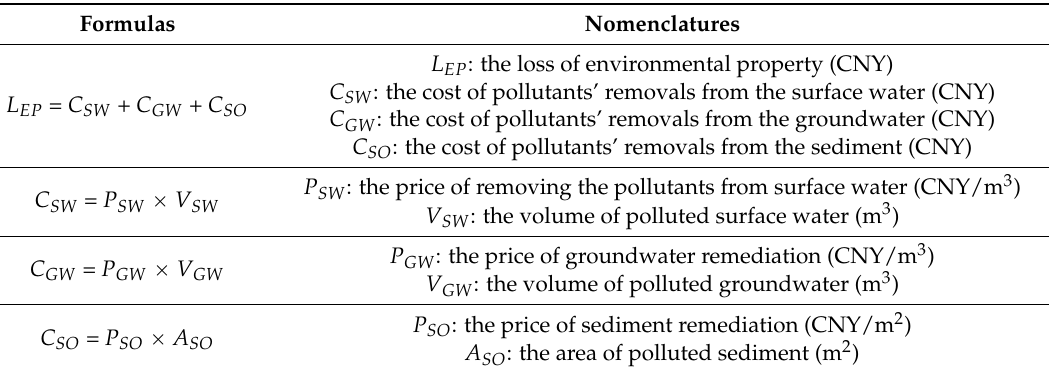
Table 5. The formulas and nomenclatures of the estimation on environmental property